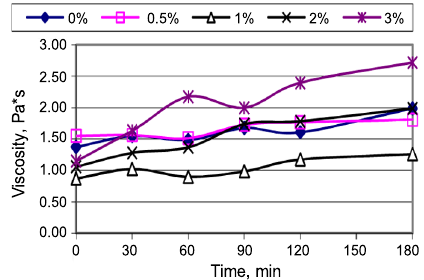
Fig. 13. Cement paste with CEM II R viscosity at shear rate 100 1/s (b) vs time after mixing